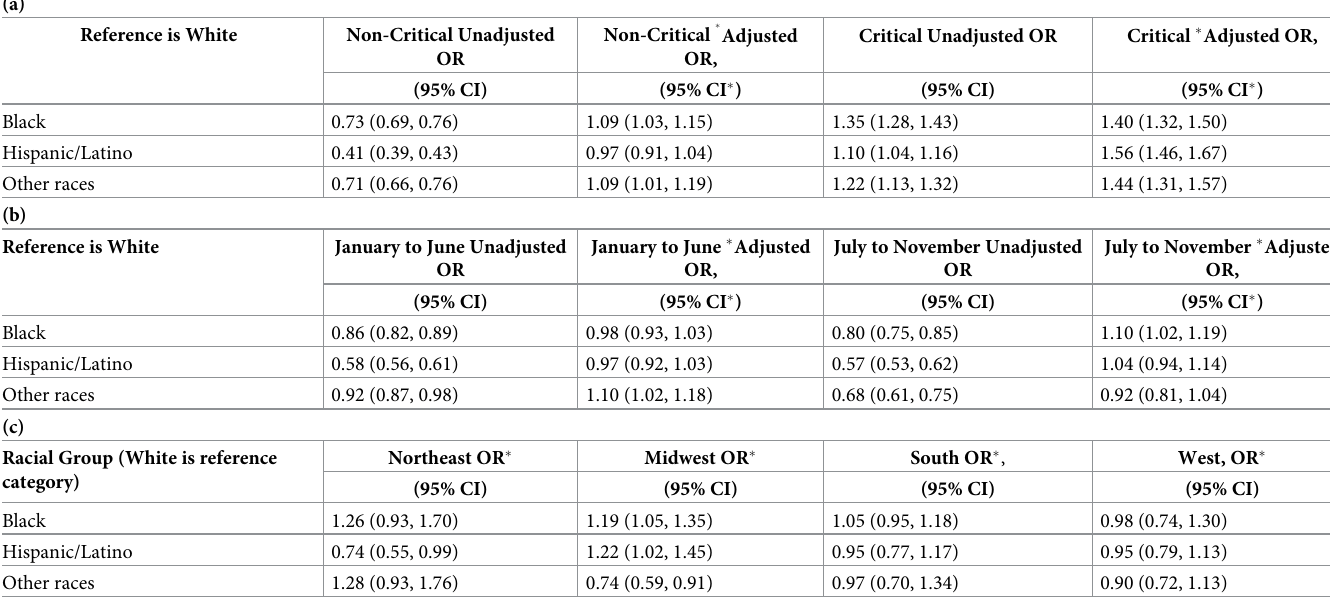
Table 4. a: Logistic regression results for racial disparities in mortality among hospitalized COVID-19 patients stratified by disease severity. b: Logistic regression results for racial disparities in mortality among hospitalized COVID-19 patients, stratified by periods of the pandemic. c: Comparing disparities in mortality among hospi- talized COVID-19 patients in July to November, across the 4 census regions.